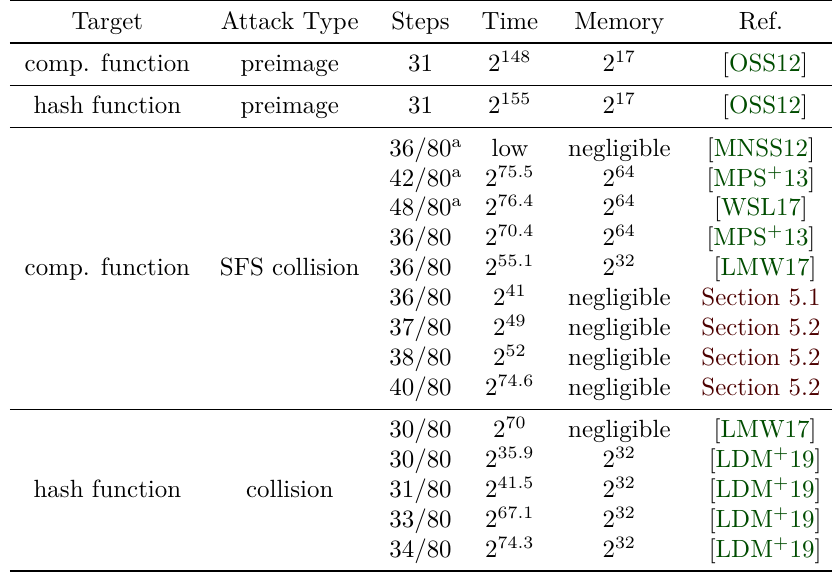
37/80 Section 5.2 30/80